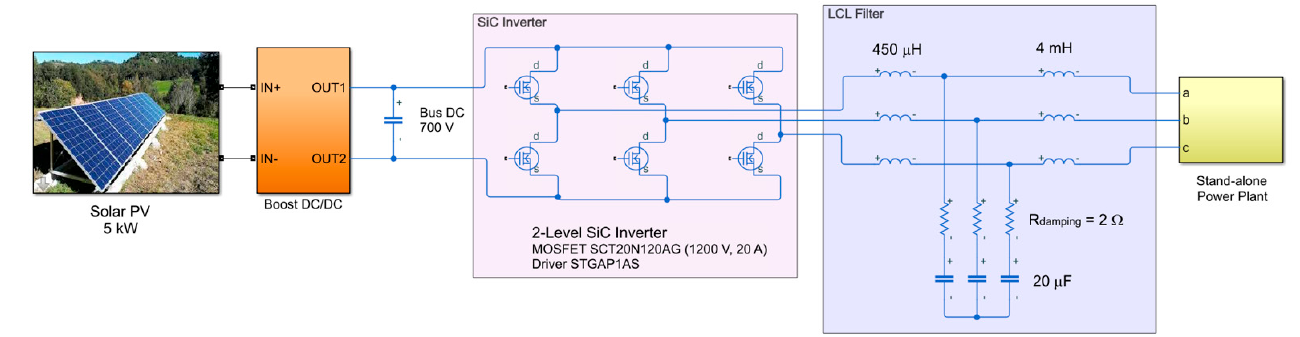
Figure 3. Schematic of the solar photovoltaic (PV) silicon carbon (SiC) inverter.